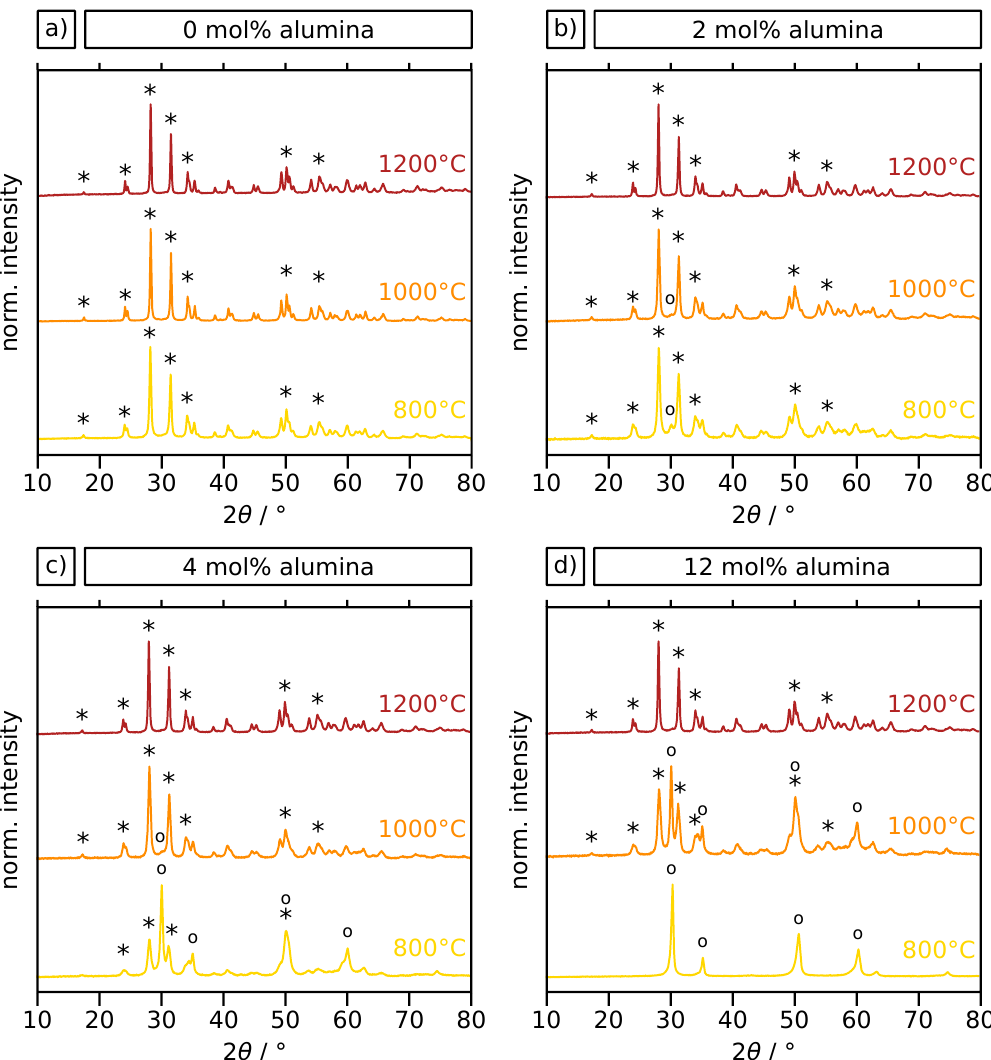
Figure 4. XRD diffractograms of zirconia particles doped with ( a ) 0 , ( b ) 2, ( c ) 4 and ( d ) 12 mol% alumina, after annealing at 800, 1000 and 1200 ◦ C for 3h. Selected peaks of monoclinic ( ∗ ) and tetragonal/cubic ( ◦ ) zirconia are indicated